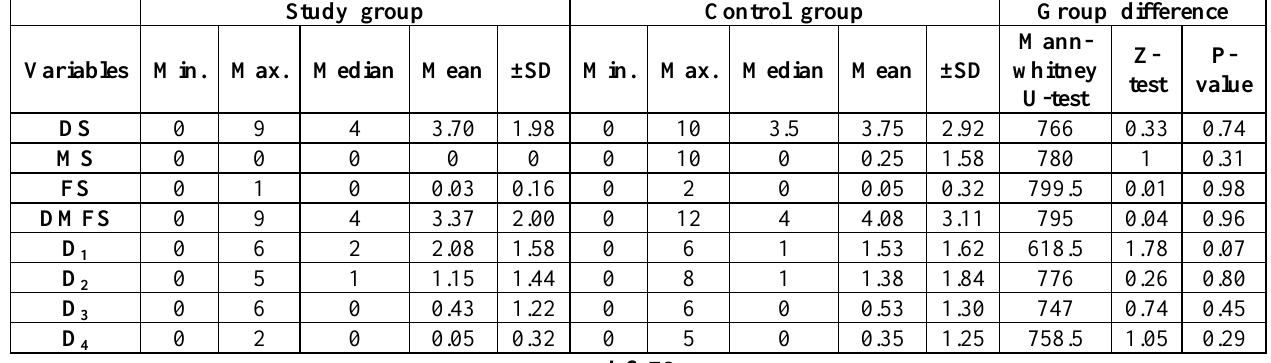
groups Control group